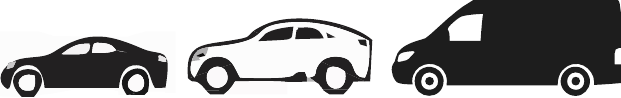
Figure 4. Vehicle types (vehicle, vehicle,